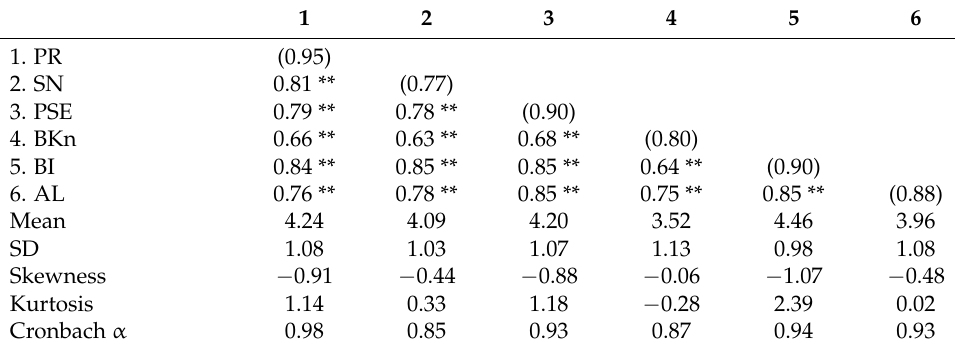
Table 2. Correlation matrix and descriptive statistics on the construct level.